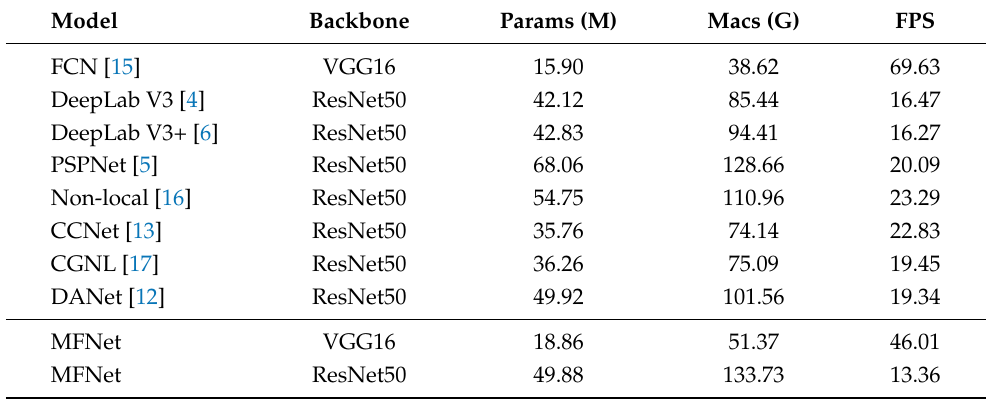
Table 14. Computational